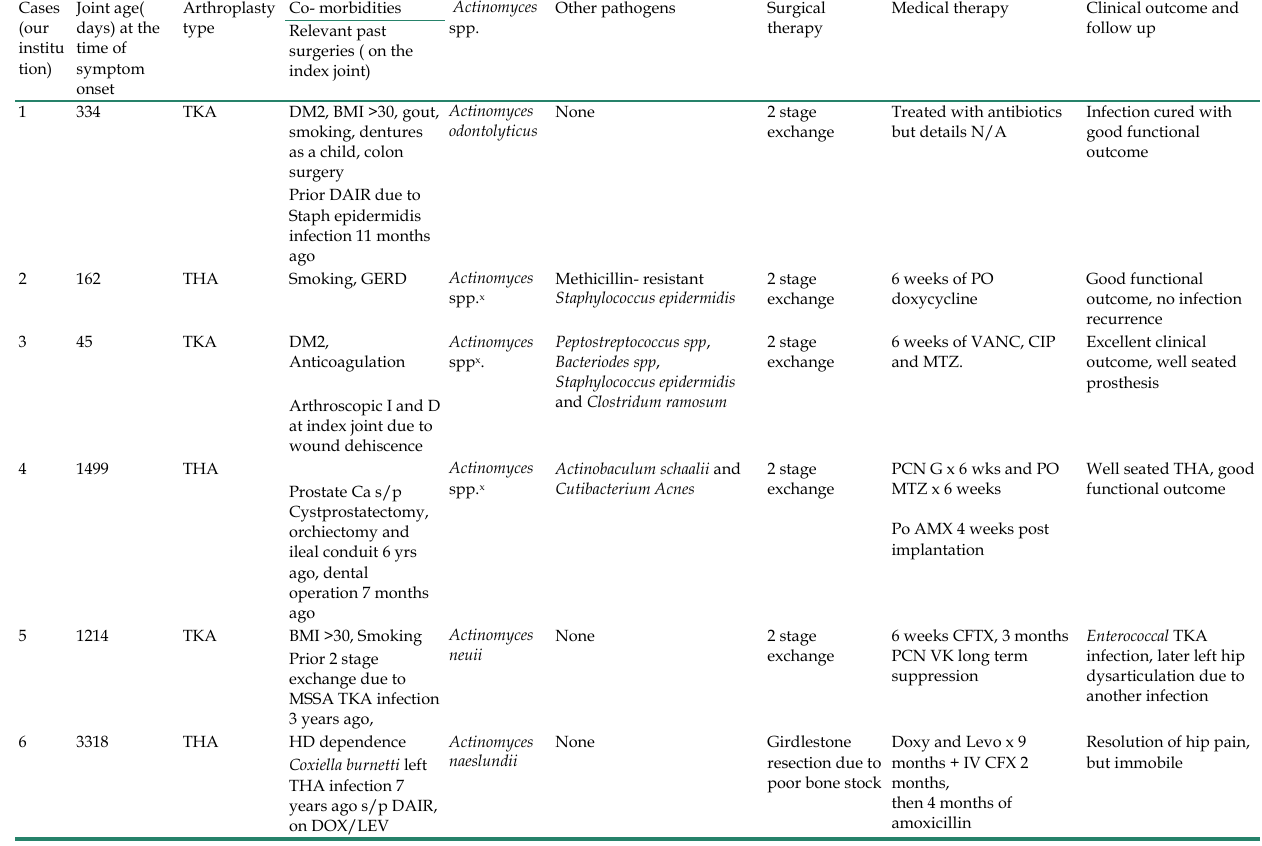
Table 2 . Cases of APJI at our institution Cases Joint age( (our days) at the institu time of tion) symptom